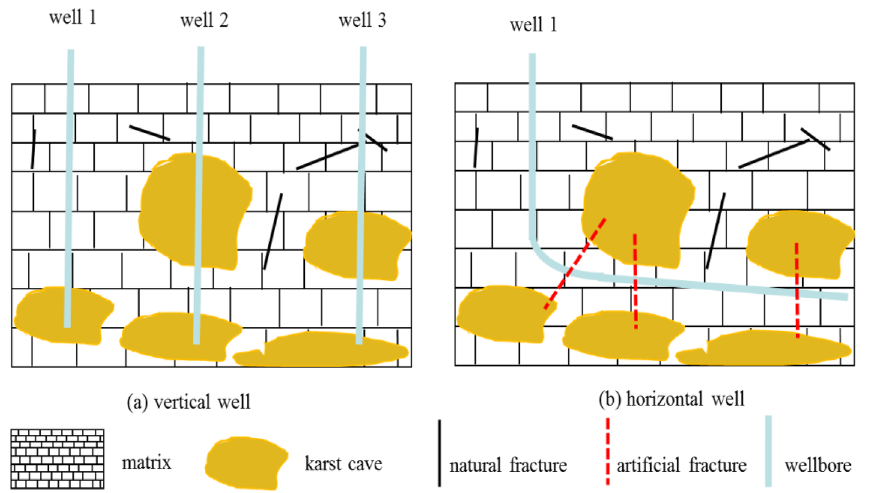
Figure 2. Schematic diagram of fracture-cavity